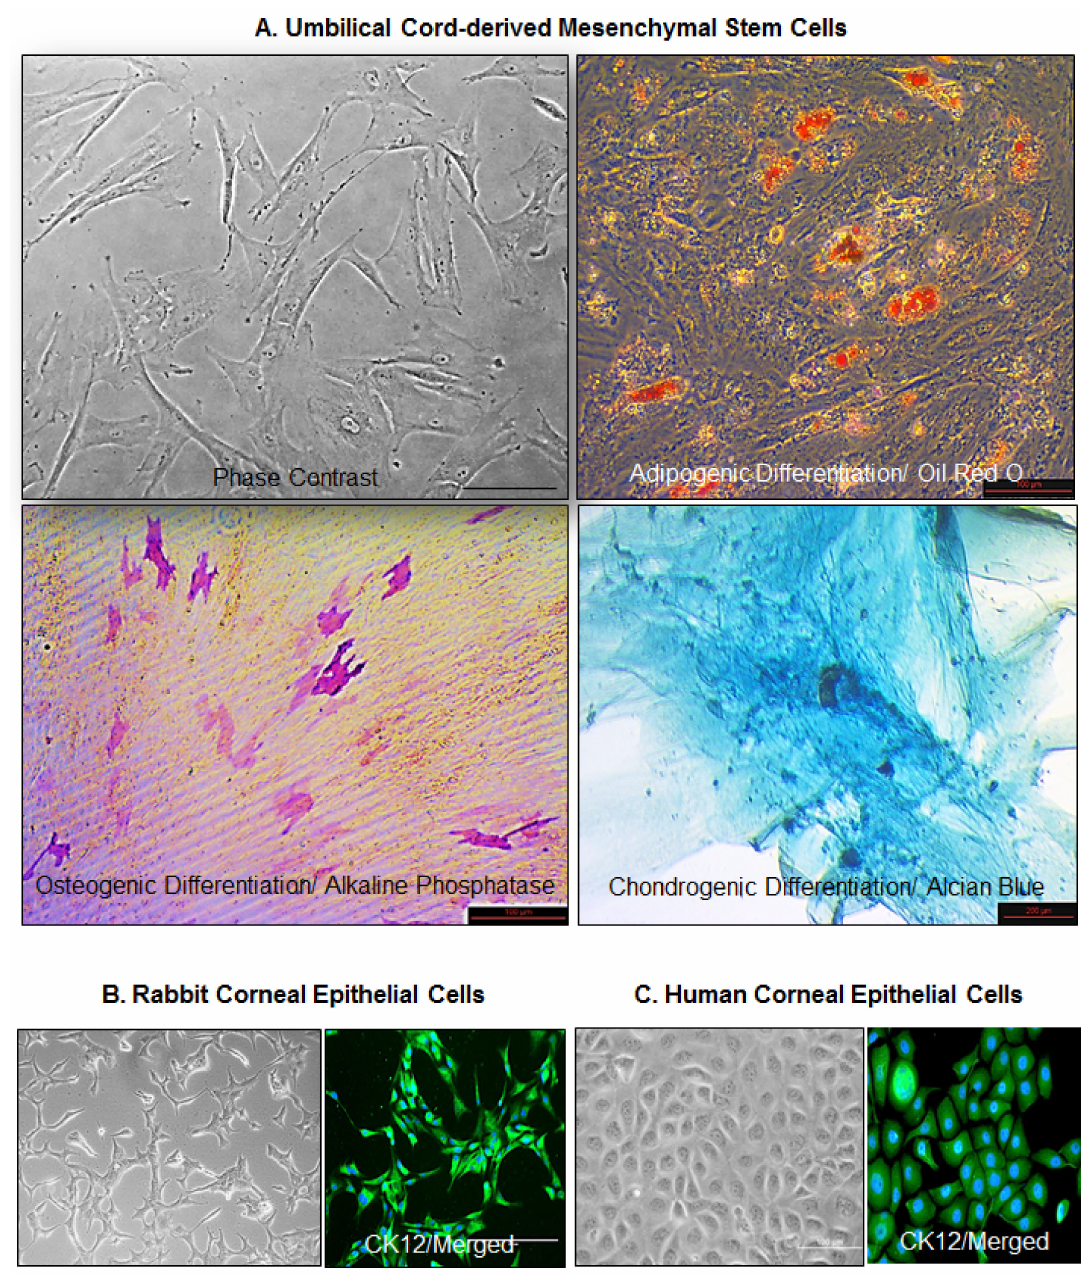
Figure 1. Culture and characterization of cells. ( A ) Umbilical cord-derived mesenchymal stem cells (UC-MSCs) were cultured in Cytomix medium (Miltenyi Biotec GmbH, Bergisch Gladbach, Germany) and their adipogenic, osteogenic, and chondrogenic differentiation was studied using Oil Red O, Alkaline Phosphatase, and Alcian Blue, respectively. ( B ) Rabbit corneal epithelial cell line (SIRC) and ( C ) Human corneal epithelial (HCE) cells were characterized by expression of CK12. Bar size: 100 µ